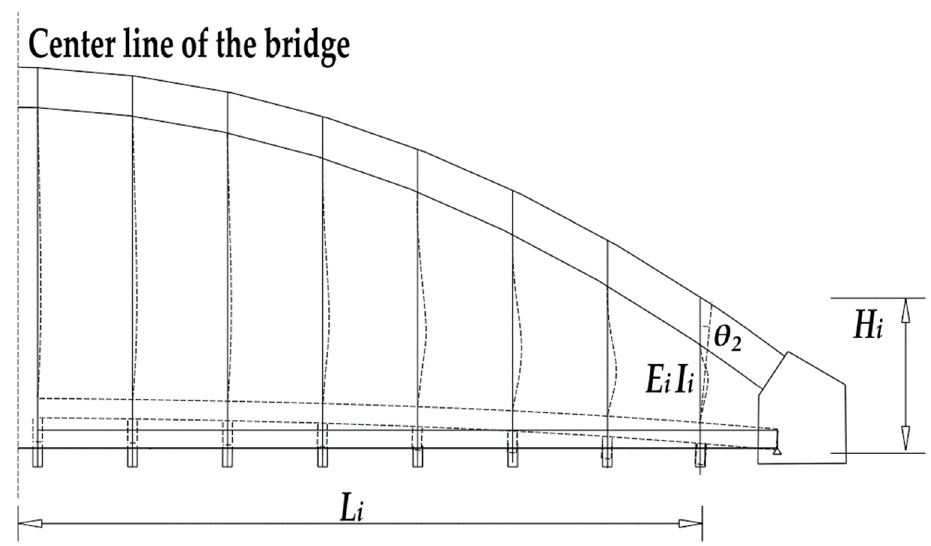
Figure 7. Bending angles caused by the rotation of the bridge decks.